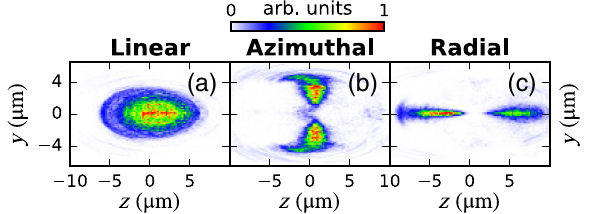
FIG. 5. Results from 3D PIC simulations. Initial position of the electrons that are ejected 4 μ m away from the plasma in the case of (a) linear, (b) azimuthal, or (c) radial polarization. In these images, a value of 1 on the color bar corresponds to 53 pC = μ m 2 for panel (a), 62 : pC = μ m 2 for panel (b), and 104 pC = μ m 2 for panel (c).